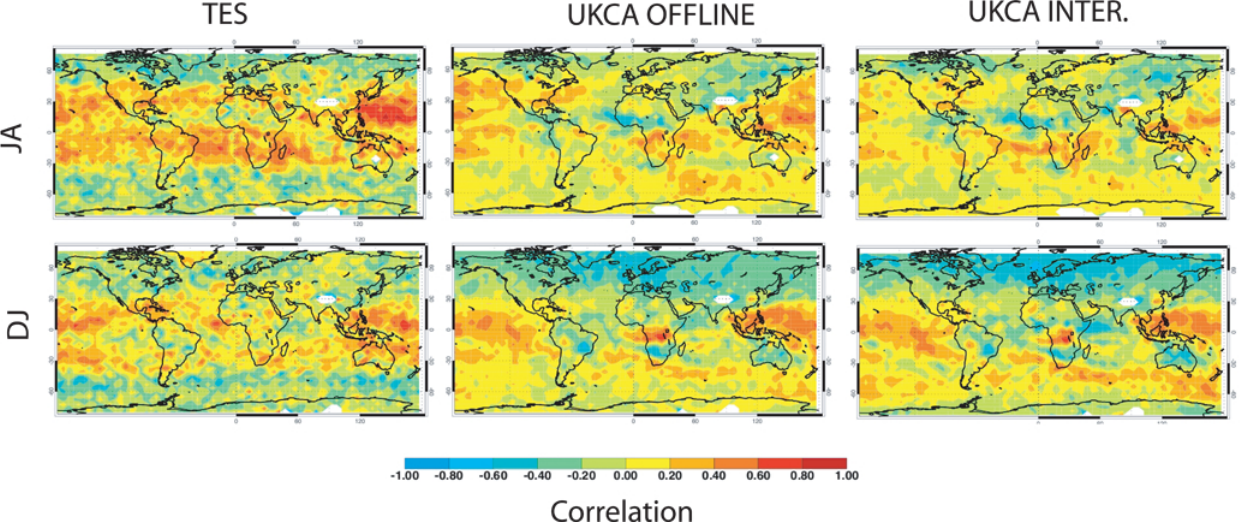
Fig. 7. Correlation between “free tropospheric” (800–400hPa) Ozone and Carbon Monoxide from 2005–2008 July/August (top row) and December/January (bottom row). Left column: observations from TES. Middle column: model with offline photolysis. Right column: model with interactive photolysis.